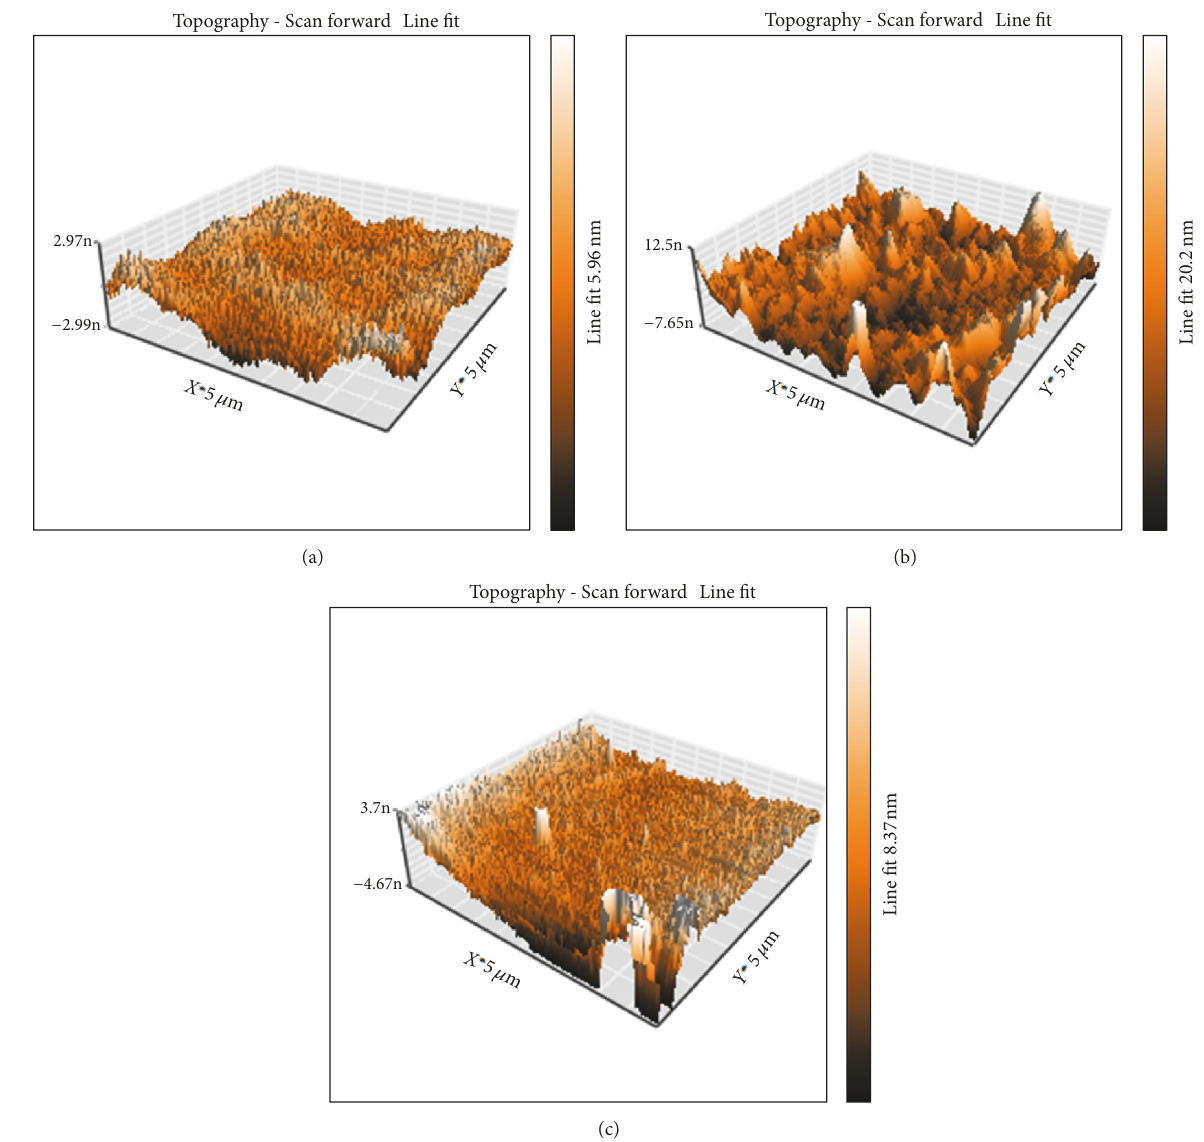
Figure 7: AFM images of terphenyls deposited over glass substrates: (a) T12, (b) T12-CN, and (c)